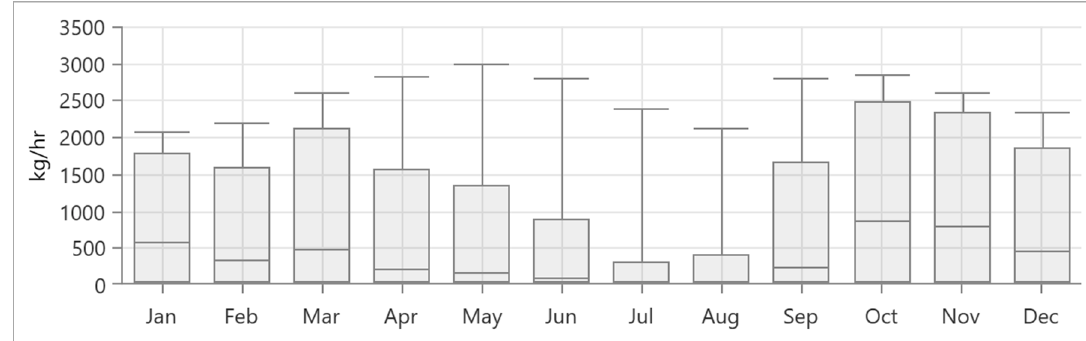
Table 4. Fuel cell operation.